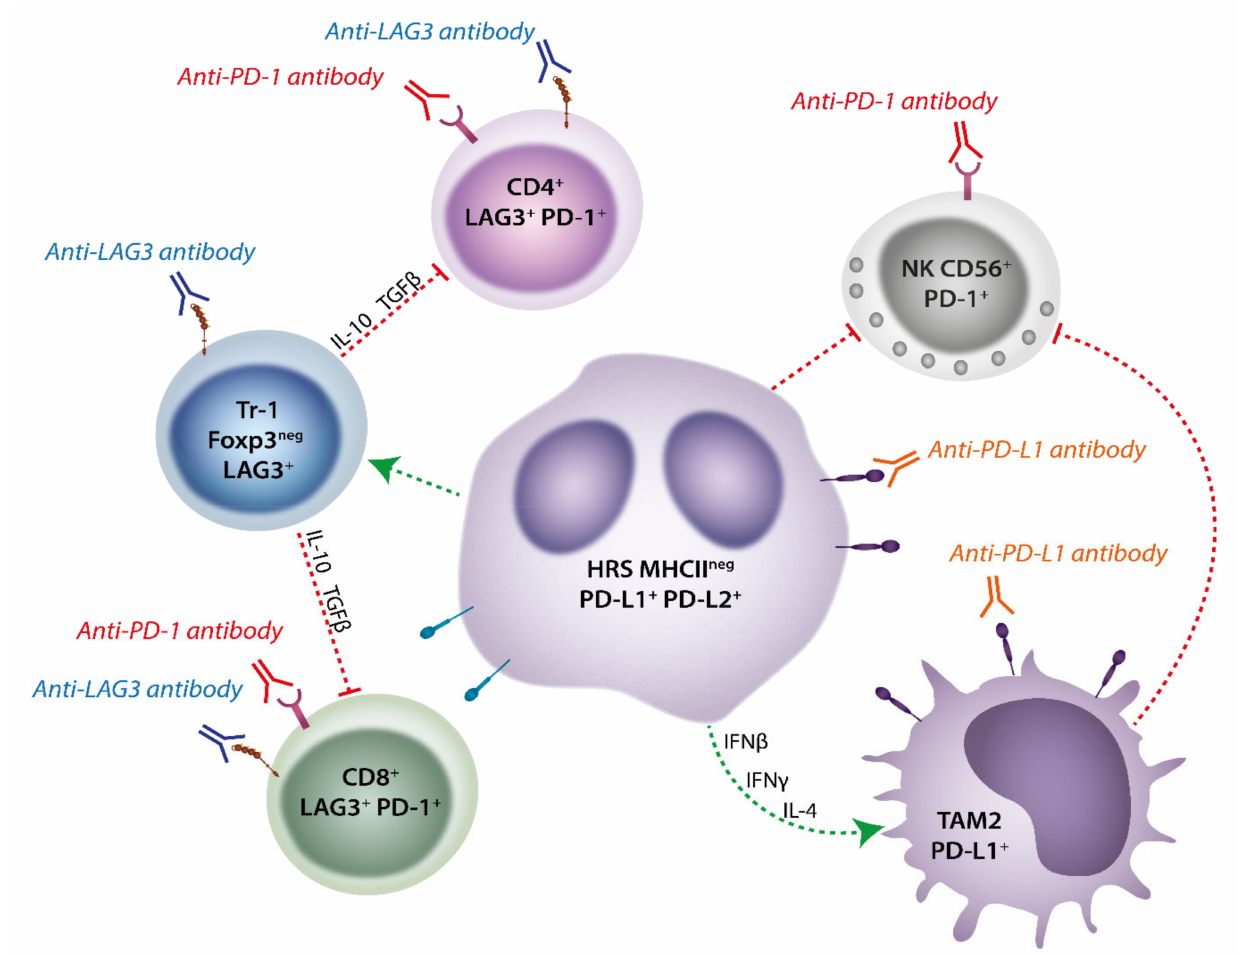
Figure 3. MHC-II Deficient Classical Hodgkin Lymphoma Fosters a Unique Tumor Microenvironment that is amenable to dual LAG-3/PD-1 blockade. In cHL cases MHC-II deficient HRS cells can form an immunotolerant environment by the enrichment of type 1 TREG (Tr1) cells that are defined by high expression of LAG-3 and lack of Foxp3. These cells secrete immunosuppressive cytokines (i.e., IL-10 and TGF β ) that contribute to the exhaustion of both CD8 + and CD4 + effector T-cells. PD-L1 is highly expressed on HRS cells (driven by 9p24.1 genomic alterations as well as TAMs which are skewed towards the PD-L1-expressing M2 phenotype by HRS cells secretion of inflammatory cytokines (IL-4, INF γ , INF β ). This high expression of PD-1 ligands in the microenvironment further inhibit effector T-cell function as well as CD56+NK cells, which are integral immune effectors in MHC deficient tumors. Application of anti-LAG-3 and/or anti-PD-1 antibodies can inhibit Tr-1 cells and disinhibit effector NK, CD4 + , or CD8 + cells, whereas anti-PD-L1 blockade targets TAMs and HRS cells. By targeting different cell populations, anti-LAG-3 and anti-PD-1 directed therapy may be a powerful combination to reinstate immune control in cHL that lacks MHC-II